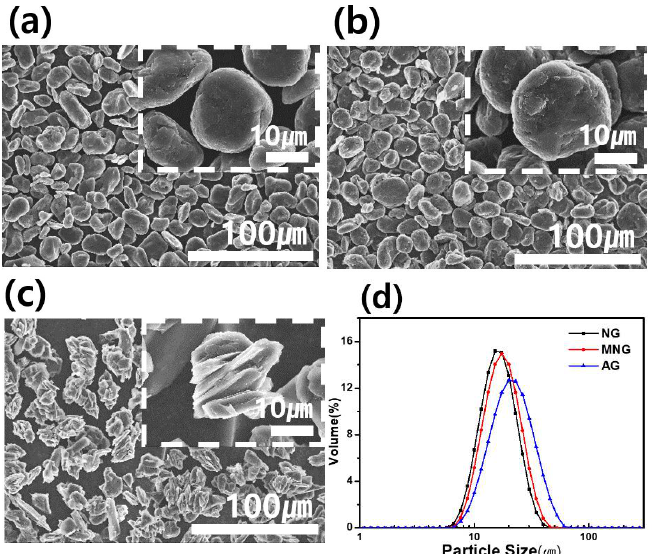
Figure 1. FE–SEM images of ( a ) pristine natural graphite (NG), ( b ) modified natural graphite (MNG), ( c ) artificial graphite (AG), and ( d ) particle-size distribution of NG, MNG, and AG sample s.